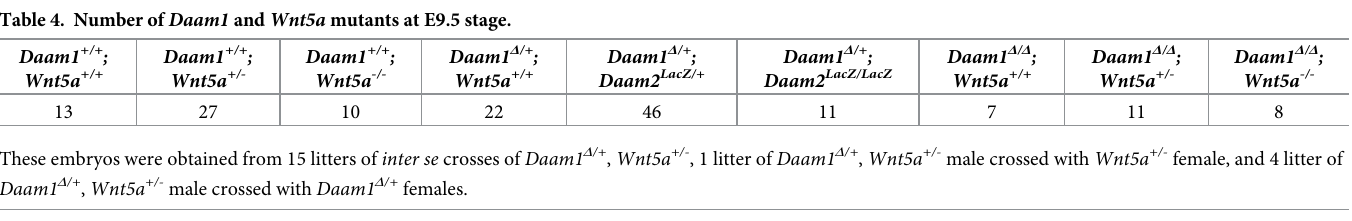
Although Daam1 was originally identified as a regulator of Wnt/PCP signaling [42], pheno- types characteristic of mammalian PCP mutants such as Vangl2 Lpt such as neural tube closure defects and convergent-extension defects, were not observed in Daam mutants. To investigate whether Daam1 has a role in the mammalian PCP pathway, we looked for genetic interactions between Daam1 and Vangl2 or Wnt5a mutants, both of which are components of the nonca- nonical PCP pathway [24, 54, 62, 63]. Vaginal atresia or imperforate vagina is a little-discussed but frequently observed phenotype of Vangl2 Lpt mice [63], including our colony of Vangl2 Lpt/+ females (7 of 15 mice). This frequency increased when crossed with the Daam1 Δ /+ background (13 of 15 Daam1 Δ /+ ; Vangl2 Lpt/+ females). However, vaginal atresia in Daam1 Δ /+ ; Vangl2 Lpt/+ female mice precluded the generation of Daam1 Δ / Δ ; Vangl2 Lpt/Lpt embryos. Examination of Daam1 and Wnt5a interactions at E9.5 (Table 4) revealed that Daam1 Δ / Δ ;Wnt5a +/- embryos